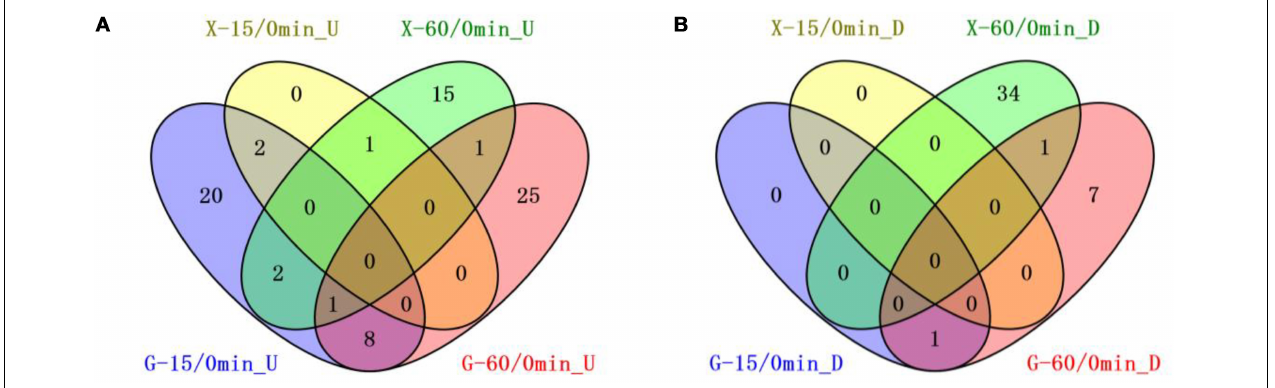
FIGURE 2 | Venn diagrams of common genetic features shared by short-term furfural shock responses in RMG8 or RMX8. (A) The furfural up-regulated features after 15 or 60 min furfural shock with at least twofold increase; (B) the furfural down-regulated features after 15 or 60 min furfural shock with at least